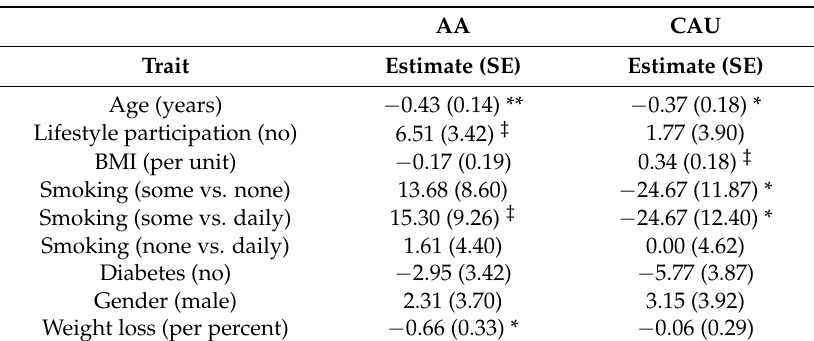
Results are reported as the estimate ( β or mean difference for continuous or nominal variables, respectively) and standard error (SE); ‡ , *, ** indicate p ≤ 0.10, 0.05, 0.01,